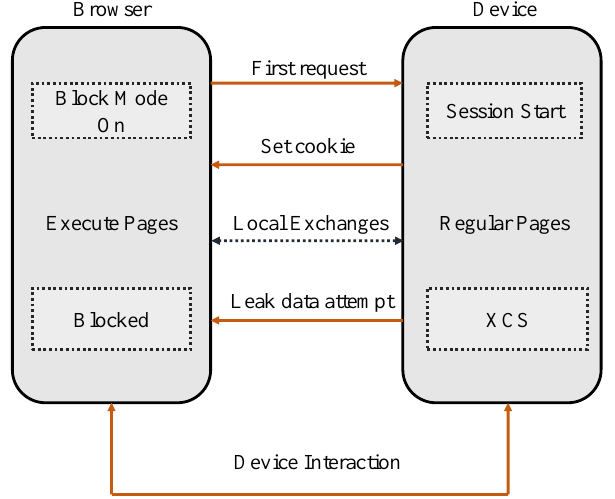
Figure 6. XCS attack prevention using contextual fingerprints.